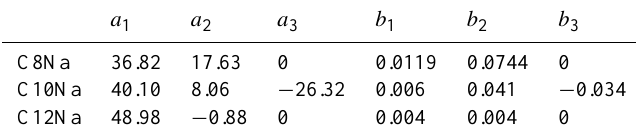
Table 3. Szyskowski (Eq. 14) fitting parameters for ternary FAS-NaCl aqueous surface tension parameterizations. Units are mN m − 1 and mol kg − 1 for parameters a and b ,